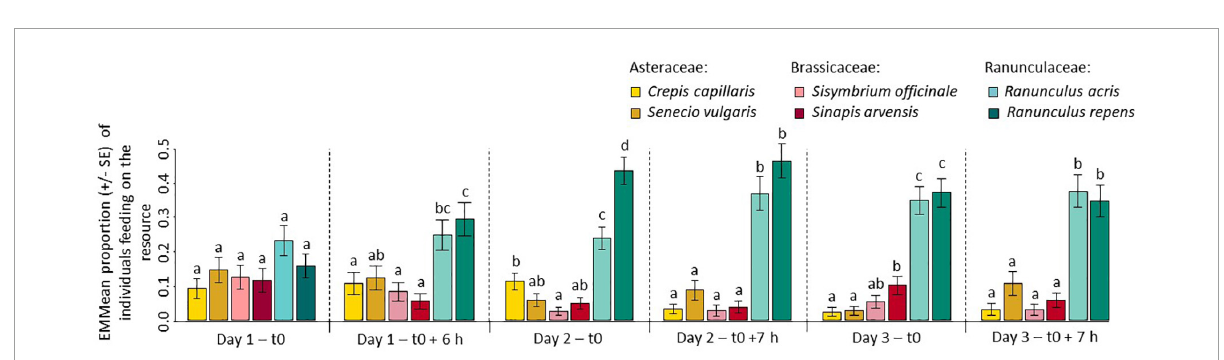
FIGURE2 The proportion of pollen beetles feeding on Ranunculaceae increases quickly over time and remains constant. Estimated Marginal Mean (EMMean) proportion ( ± SE) of individuals feeding on each resource at the first and last record of each day of the experiment. Different letters indicate significantly different EMMeans. n =